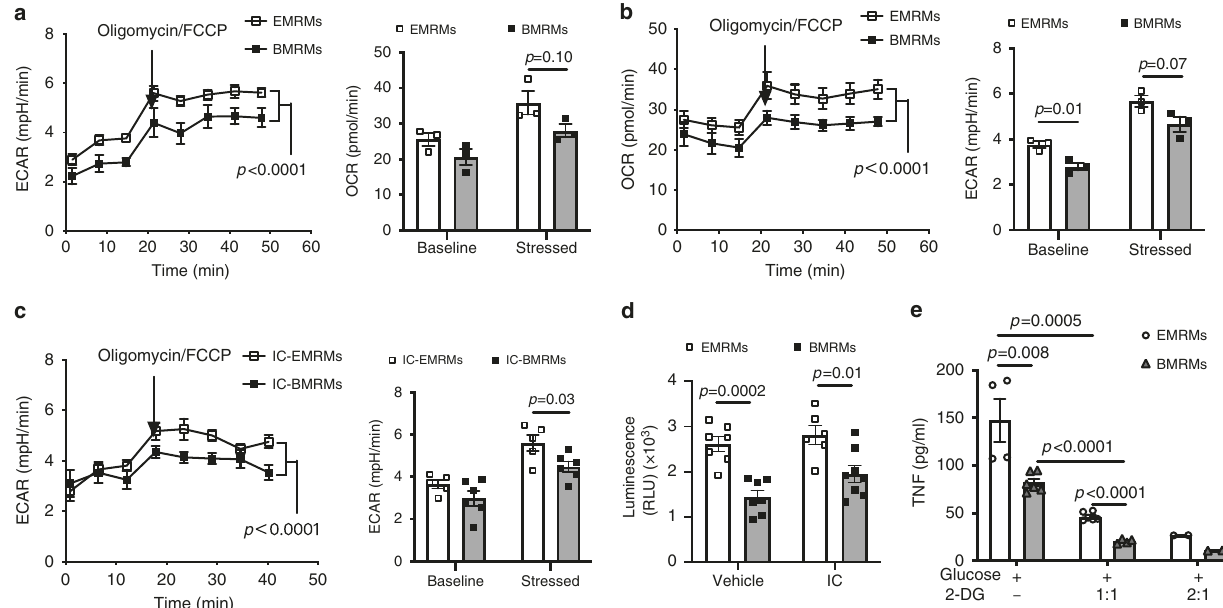
Fig. 8 EMRMs have a greater glycolytic capacity than BMRMs. a , b Real-time changes and quanti fi cations of the ECAR ( a ) and OCR ( b ) in EMRMs and BMRMs at baseline or stressed with oligomycin/FCCP. Data are representative of three independent experiments ( n = 3 per group). c Real-time changes and quanti fi cation of the ECAR in EMRMs and BMRMs sorted from Immune complex (IC)-treated mice at baseline or stressed with oligomycin/FCCP. Data are pooled from two independent experiments. ( n = 5 for IC-EMRMs; n = 6 for IC-BMRMs). d Ex vivo glucose uptake in EMRMs and BMRMs sorted from PBS (Vehicle) or IC-treated mice. RMs were sorted and treated with 2-DG for 30 min, followed by measuring the level of its product 2DG6P by luminescence reader. Data are pooled from two independent experiments. (Vehicle: n = 7 for EMRMs and BMRMs; IC: n = 6 for EMRMs and n = 8 for BMRMs). e TNF production in LPS-stimulated EMRMs and BMRMs as in Fig. 7f together with or without glucose analog 2-DG. Data are pooled from two independent experiments and each dot represents cells obtained from individual sorting. (2-DG - group: n = 4 for EMRMs and n = 6 for BMRMs; 2-DG-1:1 group: n = 6 for EMRMs and n = 4 for BMRMs; 2-DG-2:1 group: n = 2 for EMRMs and BMRMs). All data are presented as mean ± s.e.m. p -values by two- way ANOVA analysis are indicated in the left panel of a – c and by two-tailed unpaired t -test in the right panel of a – c and d , e . Source data are provided as a Source Data fi